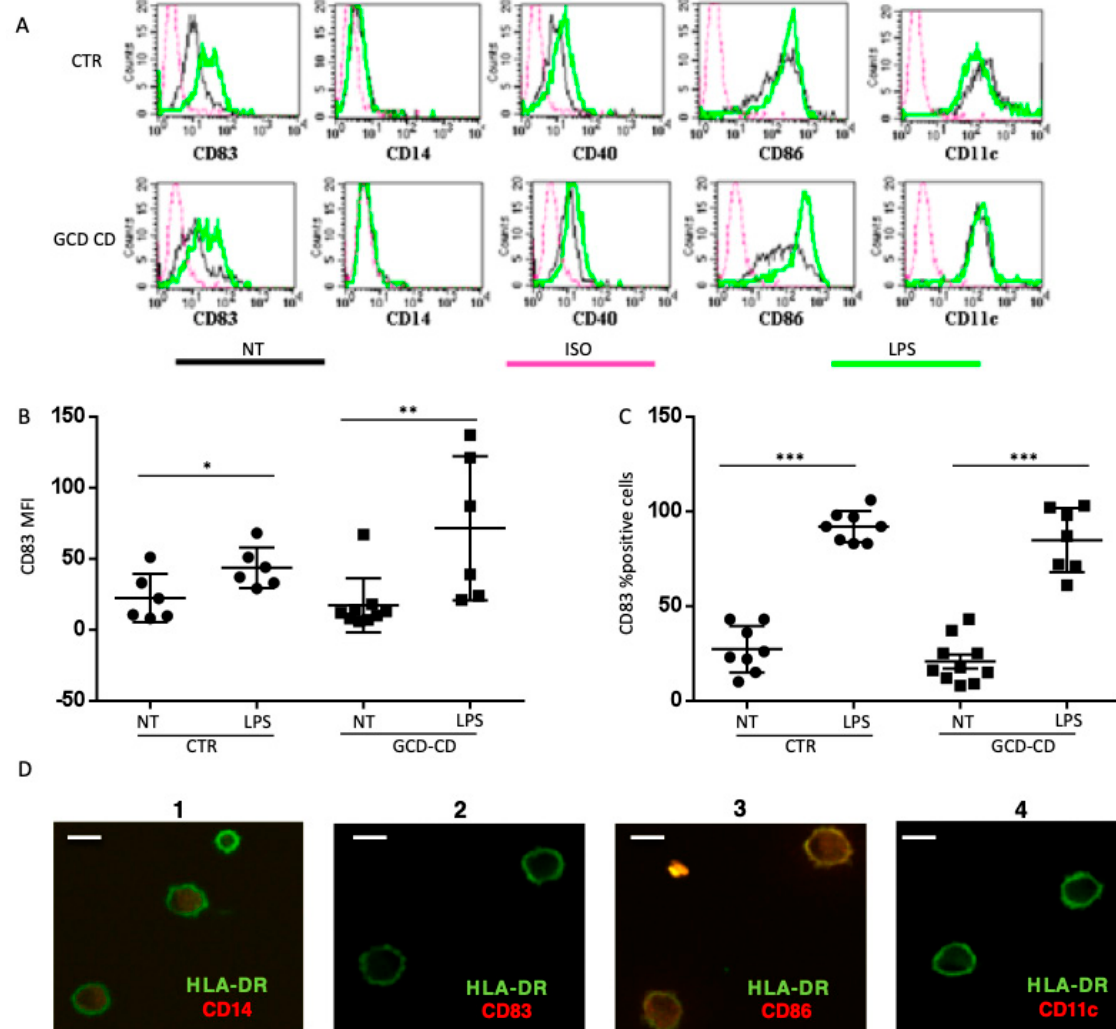
Figure 5. DCs’ surface marker profile of CD patients and controls before and after adhesion on fibronectin. ( A ). Flow cytometric analysis of DCs’ surface markers profile before interaction with fibronectin. DCs generated from peripheral monocytes were used at a concentration of 2.7–8.3 × 105 cells/mL in 24-well plates and stained with the antibodies indicated in the figure. Fluorescence intensity of the analyzed samples is represented in a histogram plot with a black line (NT, not treated); green lines refer to lipopolysaccharide (LPS)-treated samples; pink lines refer to the isotype-matched control (ISO). Representative histogram plots from one GCD-CD patient and one CTR are shown. ( B , C ). Quantification and statistical analysis of cluster differen- tiation (CD)83 surface expression as assessed by flow cytometry in DCs from CD patients and CTR showing similar CD83 surface expression levels. For CD83, mean fluorescence intensity (MFI) (B) and the percentage of positive cells ( C ) are shown. Overnight LPS treatment, used as a positive control, induced a significant increase in CD83 MFI ( B ) and the percentage of CD83 + cells ( C ) in both CTR and in CD subjects compared with non-treated (NT) cells. Each dot represents one subject. The horizontal lines represent the median; bars, the standard deviation. Student’s t -test; * p < 0.05, ** p < 0.01, *** p < 0.001. ( D ). DCs from active CD patients were plated onto coverslips pre-coated with fibronectin at a concentration of 2.5 × 10 5 cells/mL and incubated at 37 °C. To assess the surface marker profile after 3 h of adhesion on fibronectin by confocal microscopy, DCs were stained with FITC-conjugated anti-human leukocyte antigen (HLA)-DR antibody (green staining in each im- age) and with a phycoerythrin (PE)-conjugated antibody (red staining) against different surface markers, as indicated in each image. Yellow color represents merged staining. Cells appear round because of the four- degree incubation used to avoid antibody endocytosis. Representative images of at least three subjects done in duplicate are shown. More than 20 cells per patients were observed. Scale bar = 8 µm.